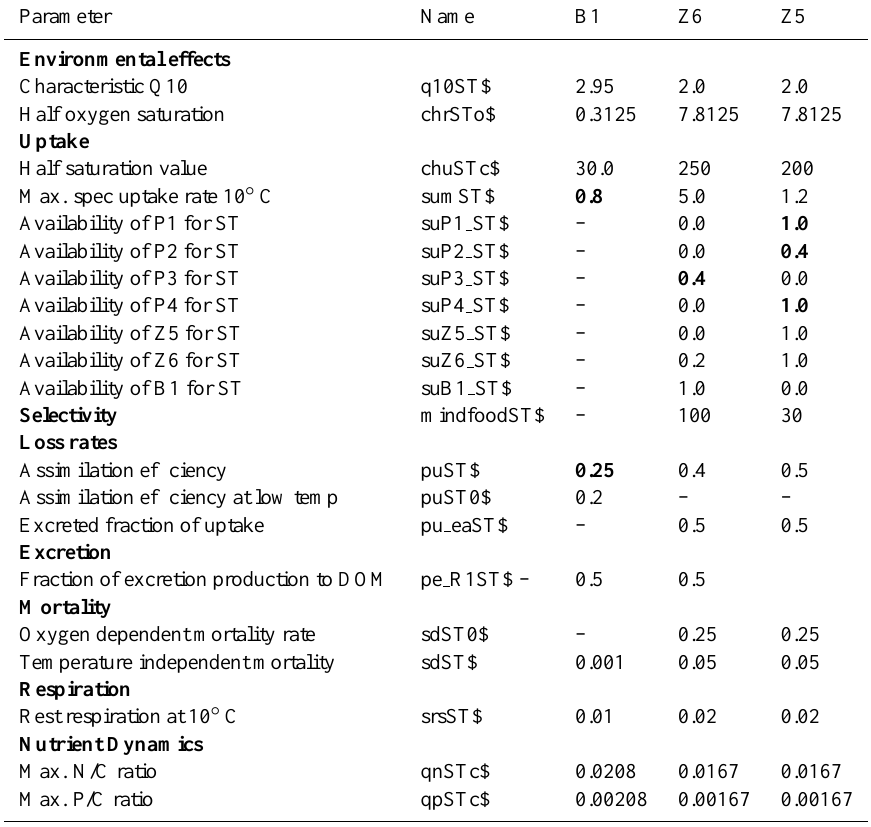
Table 2. Parameters of microzooplankton functional groups and bacteria. Z5 = microzooplankton, Z6 = heterotrophic flagellates and B1 = bacteria. The parameters that have been changed from the standard ERSEM version 11 are indicated in bold. Parameter names follow the nomenclature described by Blackford and Radford